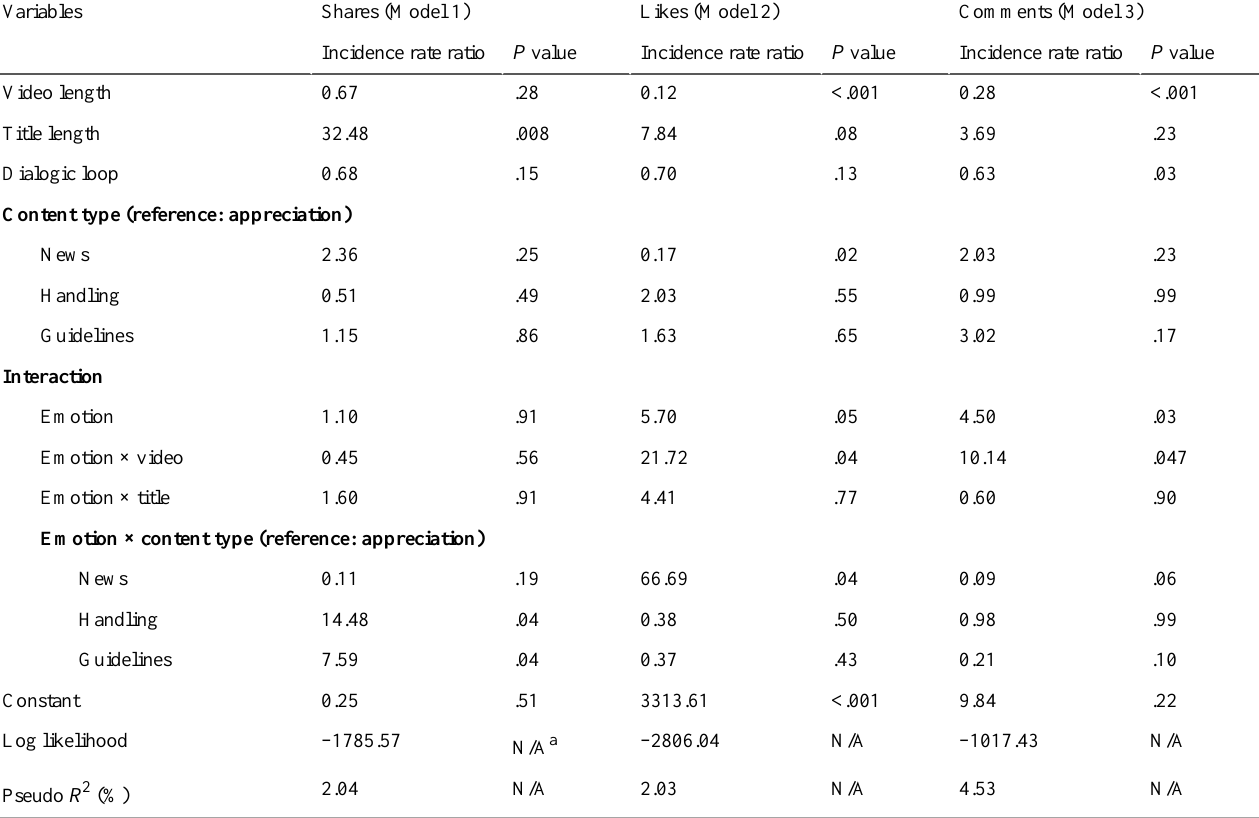
Table 3. The moderating role of emotional valence in predicting citizen